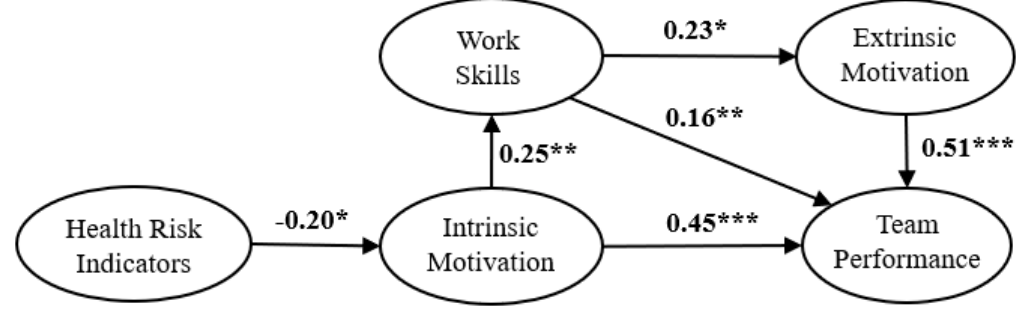
Figure 3. The standardized parameter estimates in the final model for Group B. *: p < 0.05; **: p < 0.01; ***: p < 0.001. The path coefficients are expressed in standardized estimates.